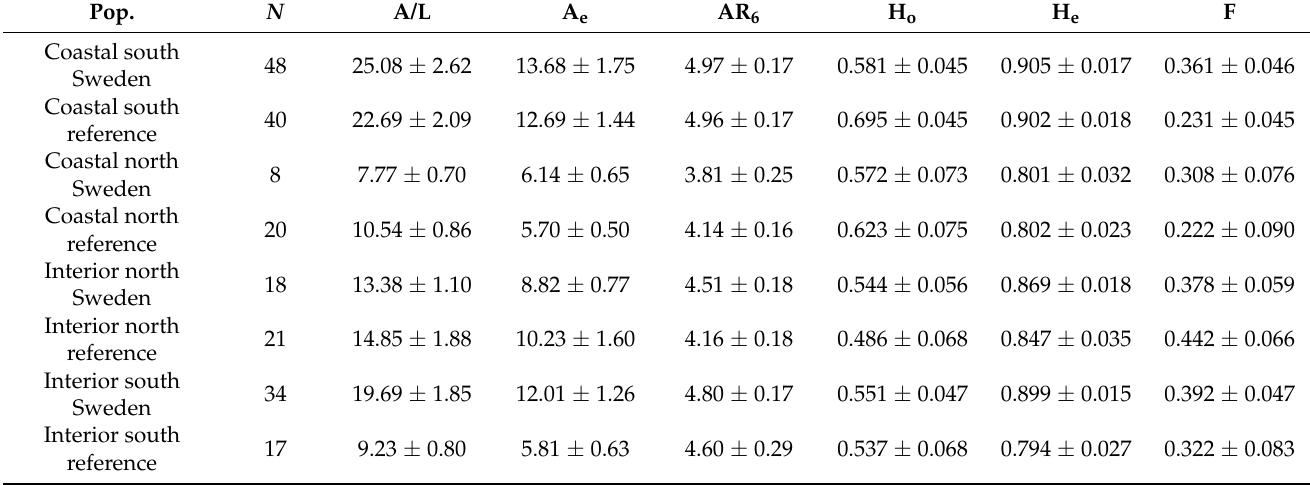
Table 5. Average ± standard error of various diversity measures for Swedish and native Douglas fir (reference populations) assigned to one of the two varieties by STRUCTURE for K = 4. A/L = number of alleles per locus, A e = effective number of alleles, AR 6 = allelic richness; rarefaction size = 6 alleles, H o = observed heterozygosity, H e = expected heterozygosity, F = fixation index.